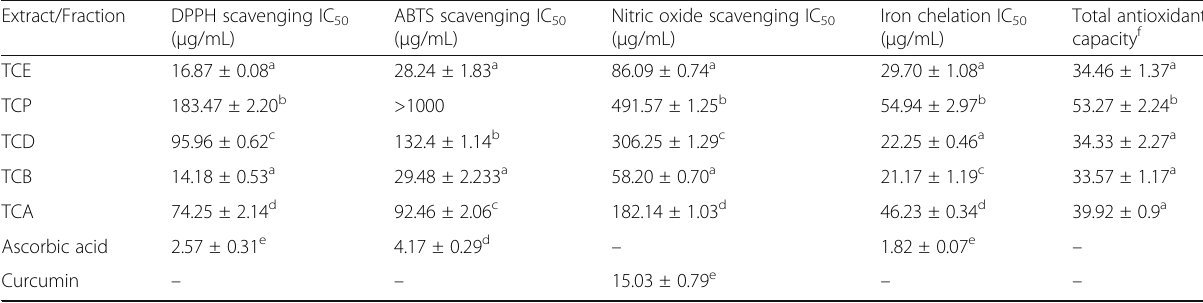
Table 2 Free radical scavenging and antioxidant capacity of extract and fractions of T cordifolia